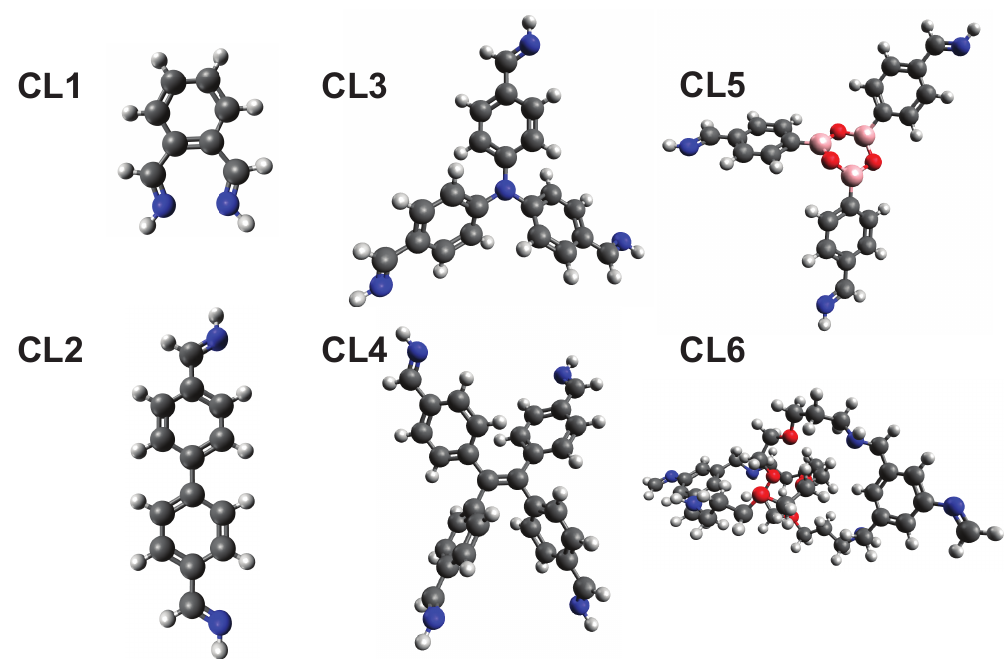
Figure 4. List of cross-linkers used for the screening. Color code: Hydrogen (White), Carbo (Black), Nitrogen (Blue), Oxygen (Red), Boron (Pink).